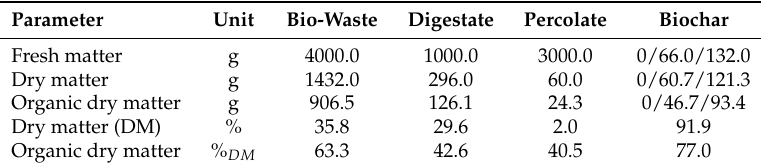
Table 4. Substrate contents for one